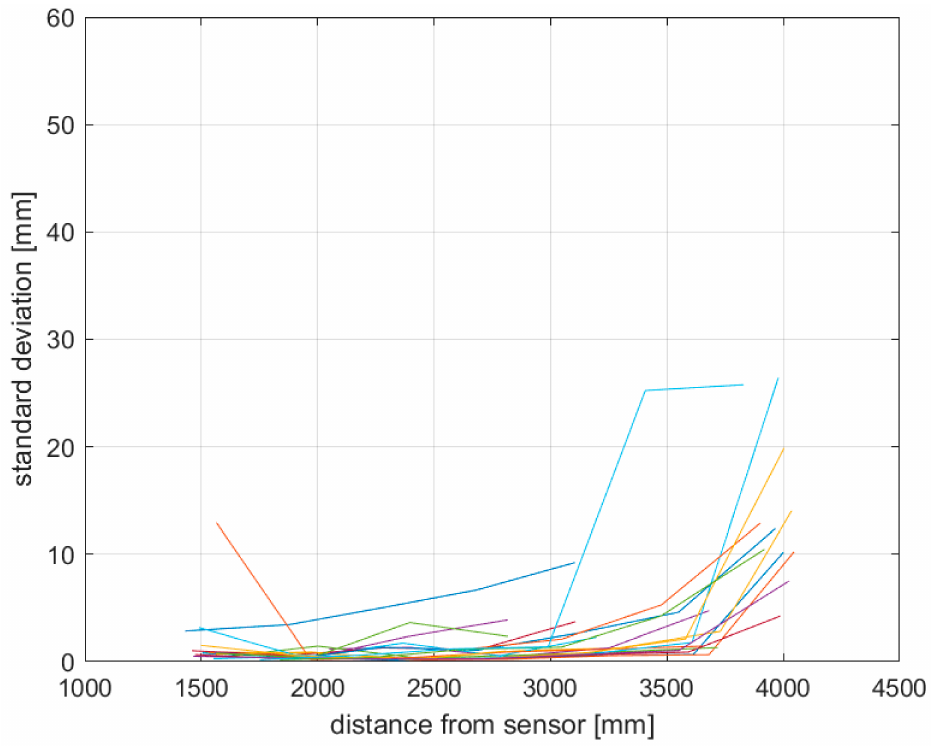
Figure 9. Body joint precision measurements of Kinect v1 with skeleton smoothing turned